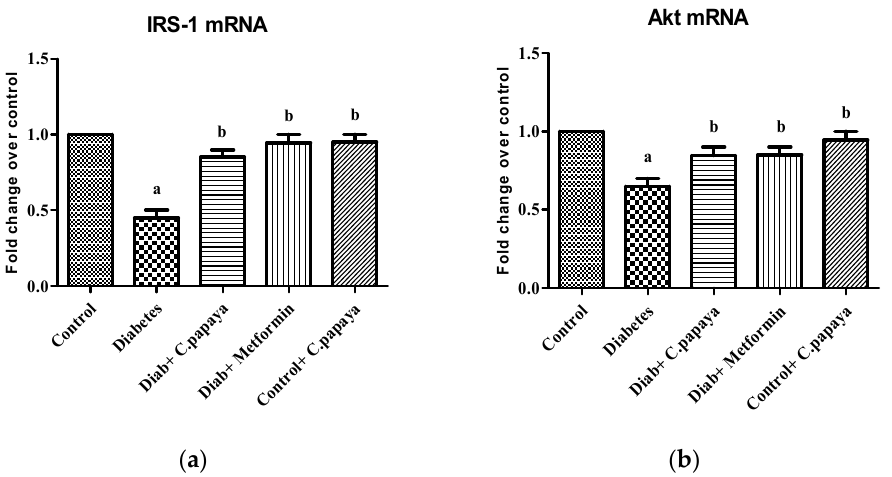
Figure 3. ( a ) IRS-1 mRNA expression levels in ethanolic extract of C. papaya in control and diabetic rats; ( b ) Akt mRNA expression levels in ethanolic extract of C. papaya in control and diabetic rats. Each bar demonstrates the mean ± SEM of eight rats, with p < 0.05 showing significant differences between the groups: a—control; b—diabetes.